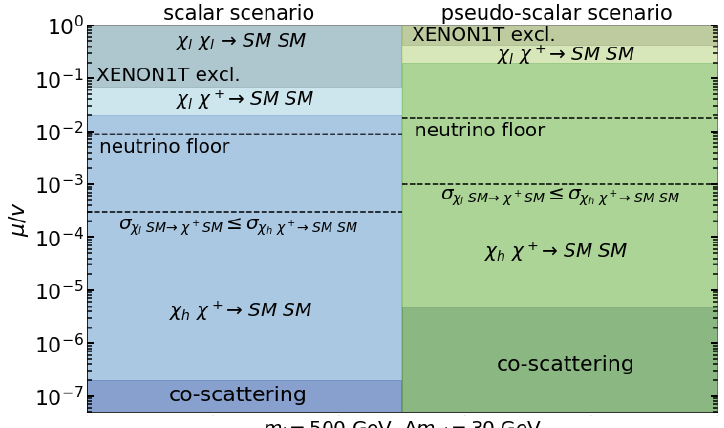
Figure 4 . Phases of dark matter freeze-out for small Higgs-portal couplings (cid:22)=v . The colored areas denote regions of pair annihilation and co-annihilation, mediator annihilation, and co-scattering, from top to bottom. Displayed processes dominate the relic abundance upon freeze-out. \SM" refers to standard-model particles f; f 0 ; V